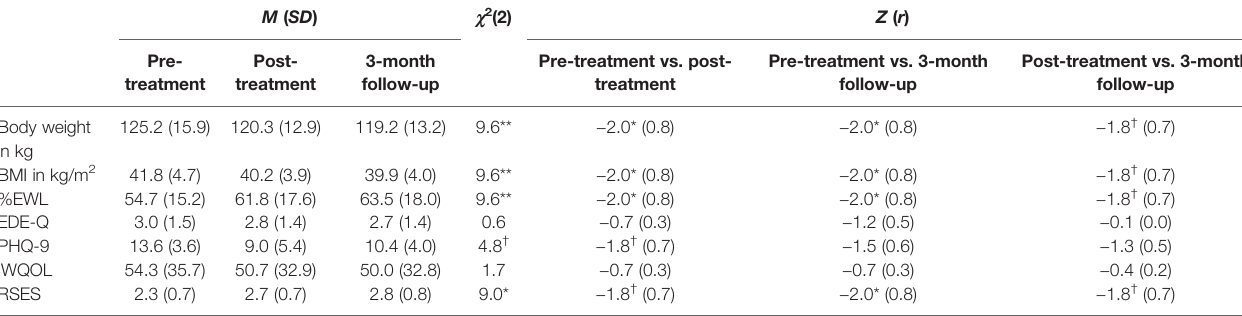
TABLE 2 | Differences in clinical variables for pre-treatment, post-treatment, and 3-month follow-up assessments. M ( SD ) c 2 (2)